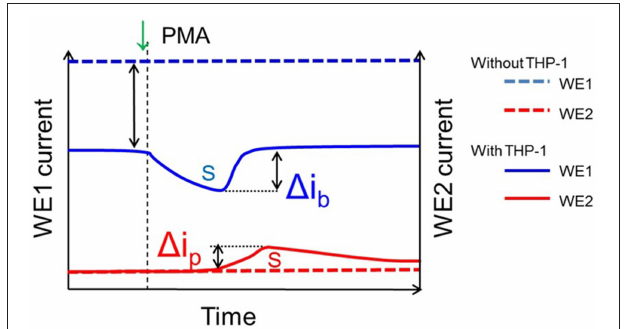
FIGURE 9 | Details showing parameters utilized for calculation of oxygen consumption and H 2 O 2 generation. The blue line (dotted) shows the bulk oxygen reduction current in system containing no THP-1 cells while the blue line (non-dotted) shows the oxygen reduction current in system containing THP-1 cells; the difference (blue dotted and blue un-dotted represents the change in dissolved oxygen concentration due to cell respiration and 1 i b represent the change in oxygen reduction current with the exogenous addition of PMA. Similarly, the red line (dotted) shows the reduction current for H 2 O 2 in system containing no THP-1 cells while the red line (non-dotted) shows reduction current for H 2 O 2 in system containing THP-1 cells and 1 i p represent the change in reduction current for H 2 O 2 with the exogenous addition of PMA. The parameters were considered for calculations of oxygen consumption and generation of H 2 O 2 as in Table 1 .